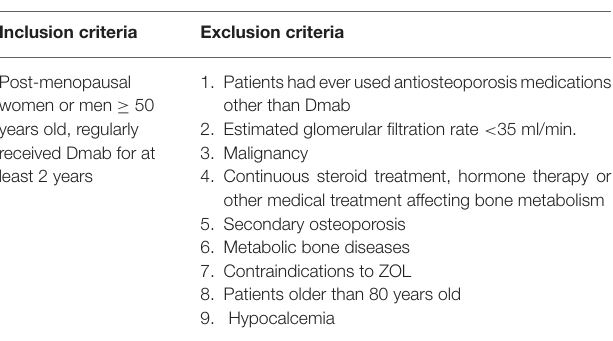
TABLE 1 | Inclusion and exclusion